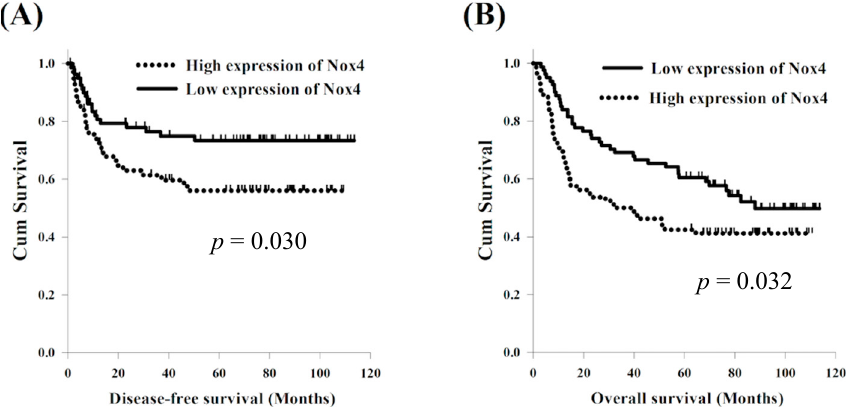
Figure 4. Comparison of survival curves for patients with oral tongue squamous cell carcinoma with high and low expression of Nox4. ( A ) Disease-free survival ( B ) Overall survival. Table 3. Univariate and multivariable analysis of disease-free survival and overall survival in 161 patients with oral tongue squamous cell carcinoma receiving surgical